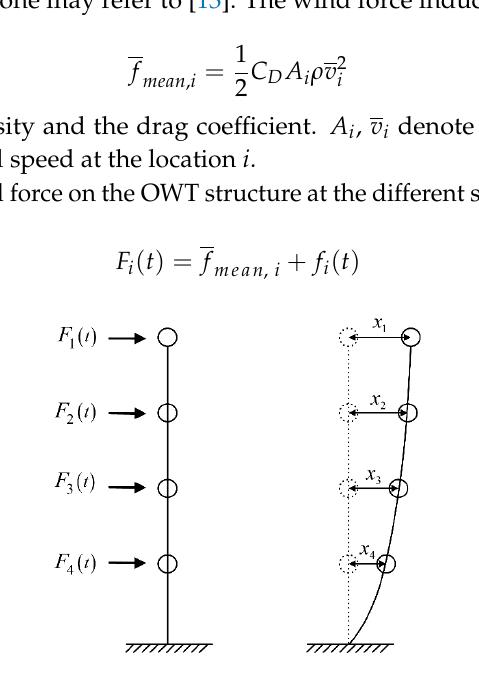
Figure 14. Wind force and displacement at different segments along the tower.